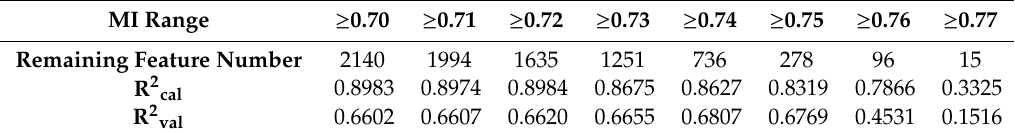
Table 3. PLSR detection results of TSS based on spectral data with MI feature elimination.